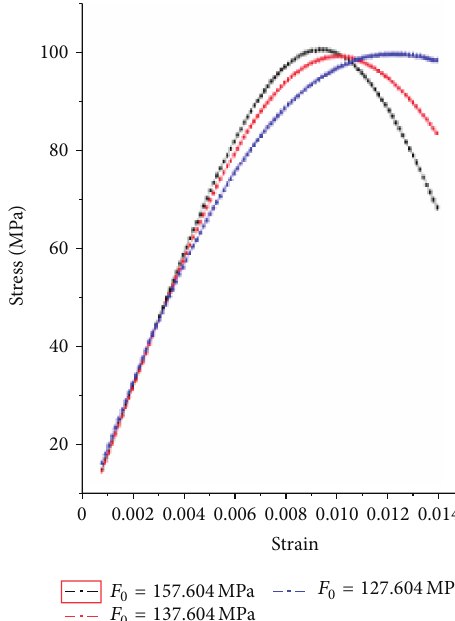
Figure 3: The effect of parameter 𝐹 0 on constitutive curve.